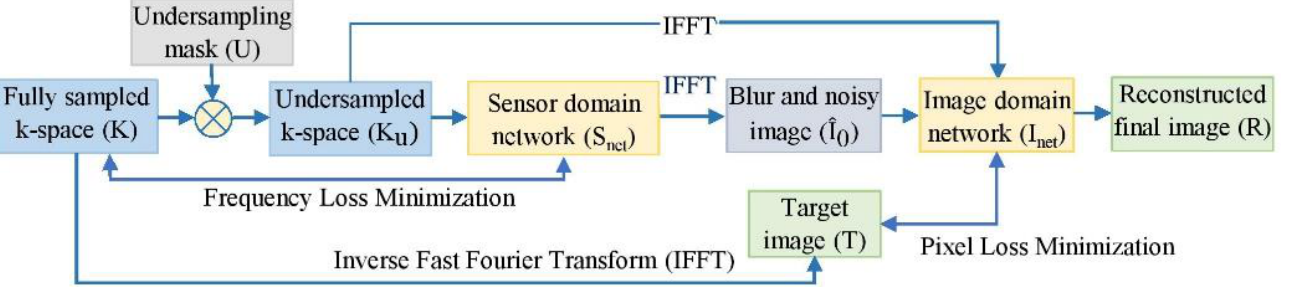
Figure 2. Flowchart of the proposed dual-domain magnetic resonance imaging (MRI) reconstruction technique.